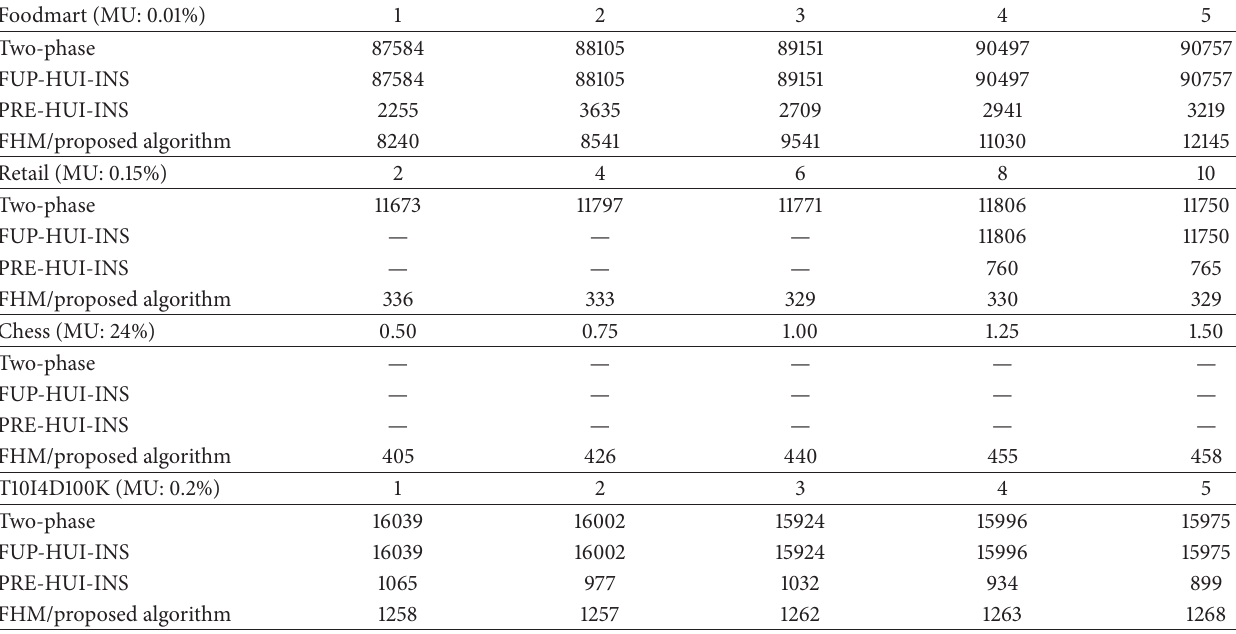
Table 9: Number of candidate itemsets and HUIs under various insertion